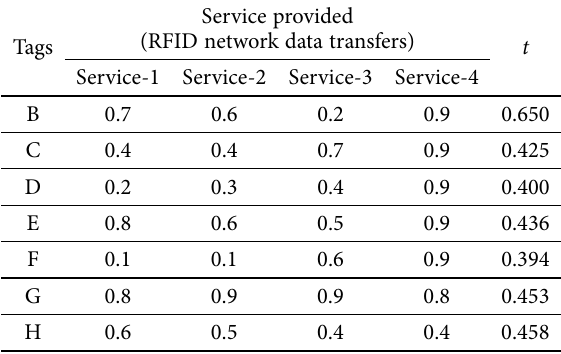
Table 6. Calculated network tags mean Priority values based on the provided services